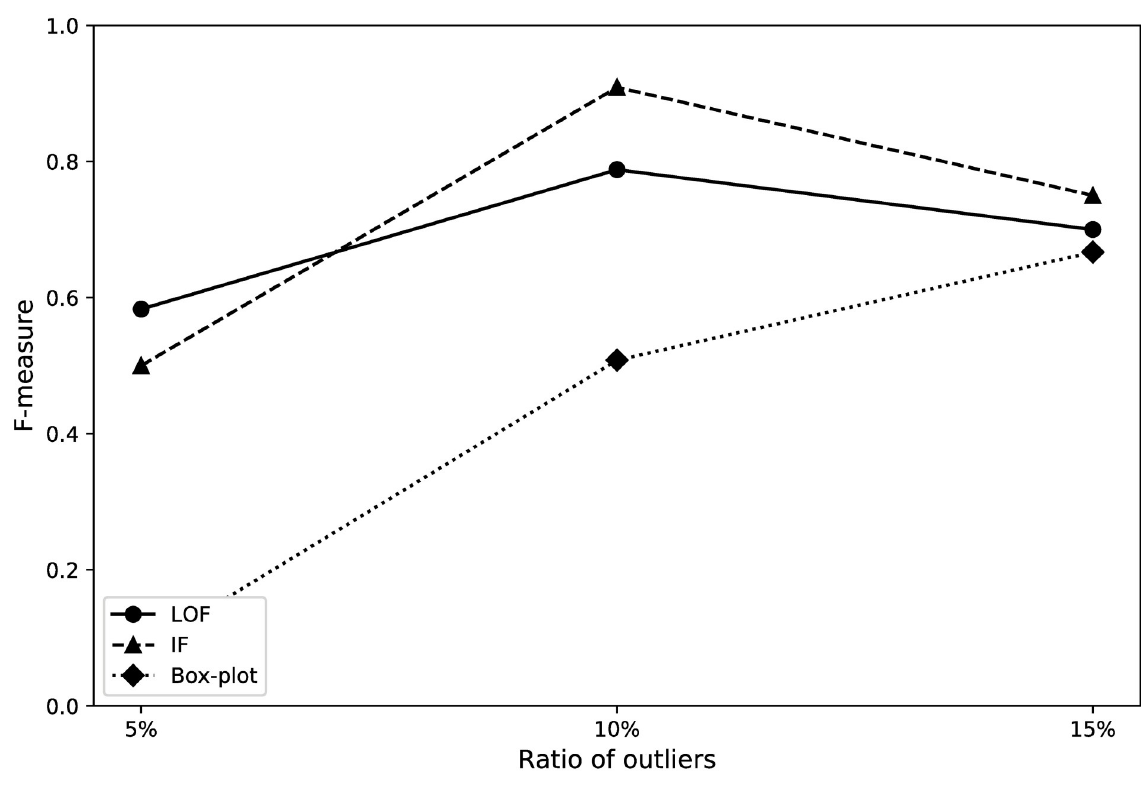
Fig 5. Performance for the city of